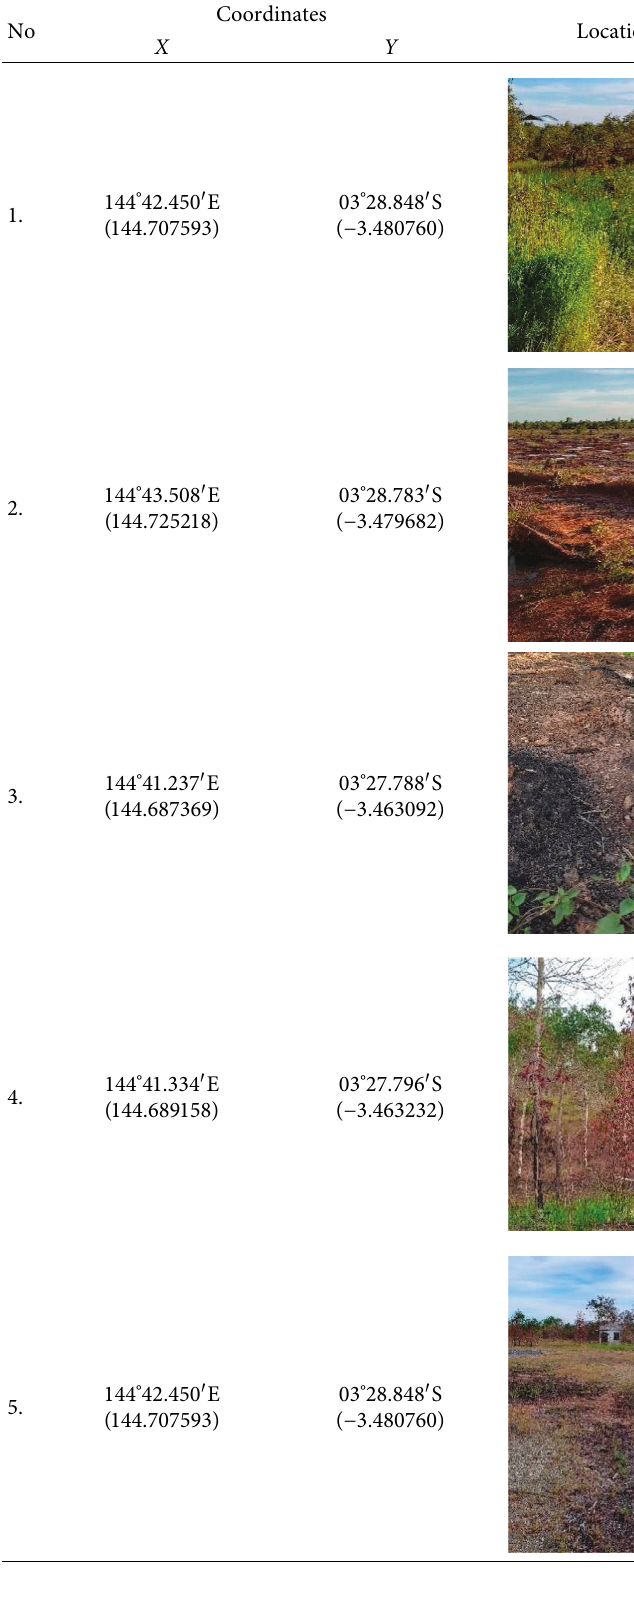
Table 4: Field validation of burned areas in